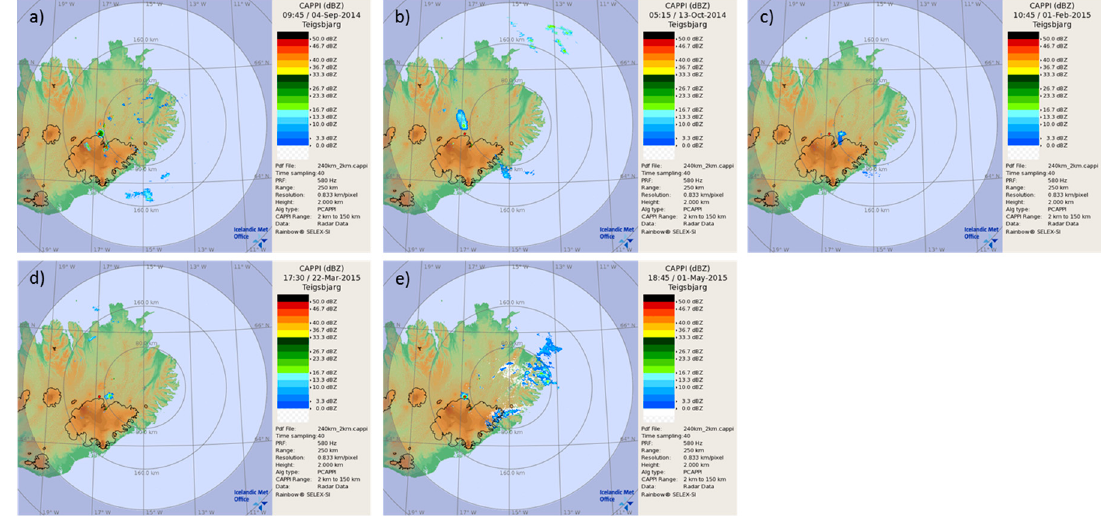
Figure 9. The radar-detectable cloud above the eruption site (indicated in red) detected by the C-band radar at Fljótsdalsheiði. ( a ) 04/09/14, ( b ) 13/10/14, ( c ) 01/02/15, ( d ) 22/03/15, ( e ) 01/05/15.